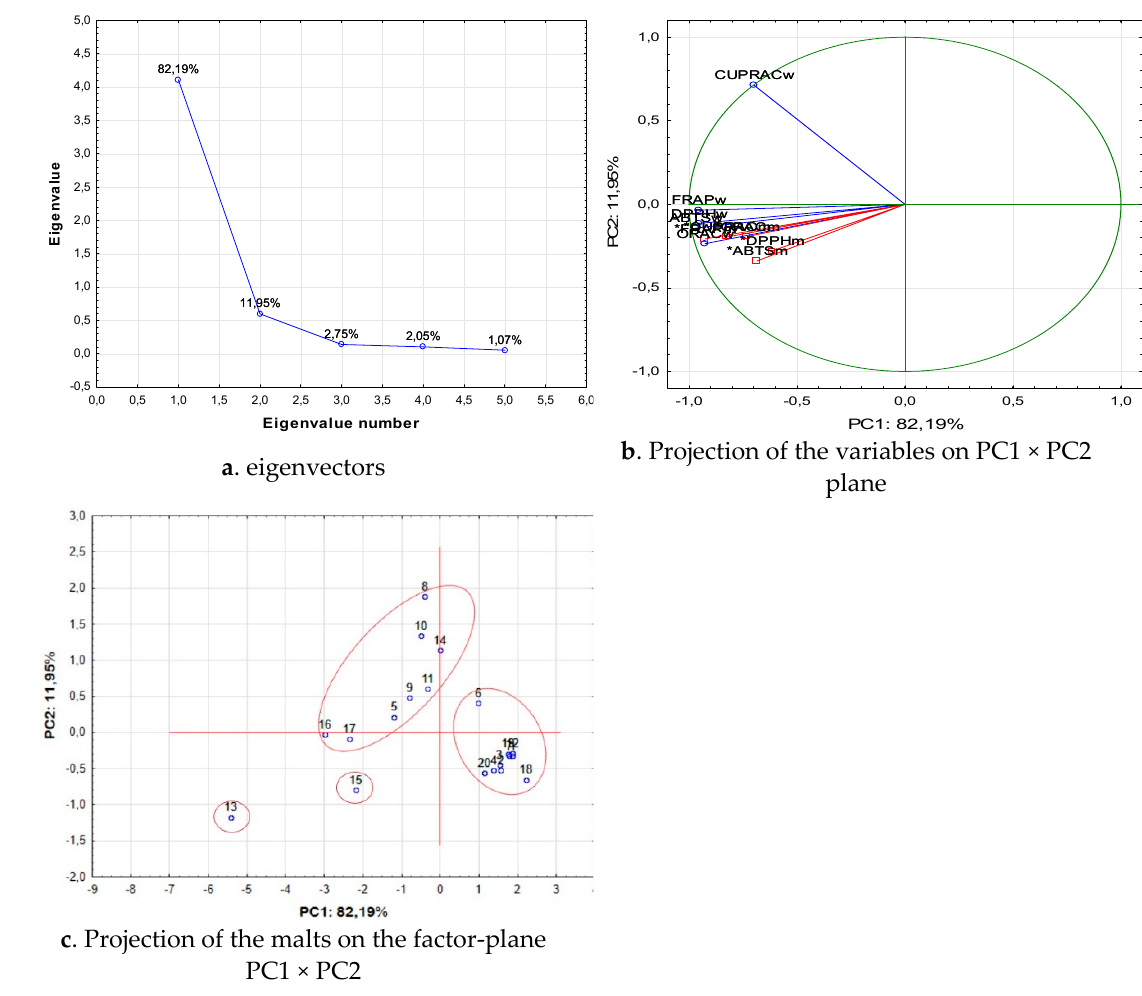
Figure 8. Classification of malts by the principal component analysis in terms of antioxidant potential. ( a ) eigenvectors; ( b ) Projection of the variables on PC1 × PC2 plane; ( c ) Projection of the malts on the factor-plane PC1 × PC2. 1—Pilsen; 2—Pale ale; 3—Vienna malt; 4—Munich; 5—Melanoidine; 6—Munich dark; 7—Wheat; 8—Red X; 9—Caramel amber; 10—Caramel hell; 11—Black; 12—Caramel pils; 13—Special X; 14—Special Wheat; 15—Caramel Munich I; 16—Caramel Munich II; 17—Chocolate; 18—Rye; 19—Acidulated; 20—Smoked malt. Legend: “,”—decimal point; “-”—minus sign; *—denotes the supplement variable during